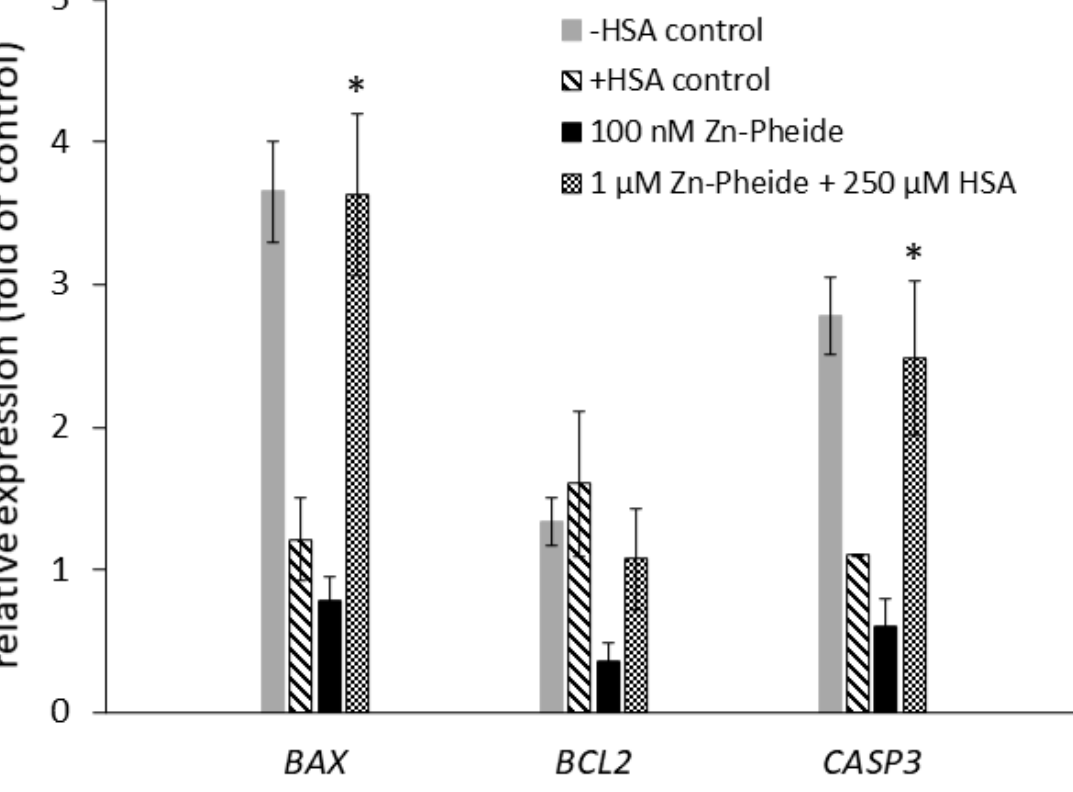
Figure 10. Relative quantification using real-time quantitative PCR of mRNA expression of BAX , BCL2 , and CASP3 genes in HUVEC cells upon Zn-Pheide-induced PDT. Data are shown as mean ± SD ( n = 4). * p < 0.05 compared to HSA-containing control.